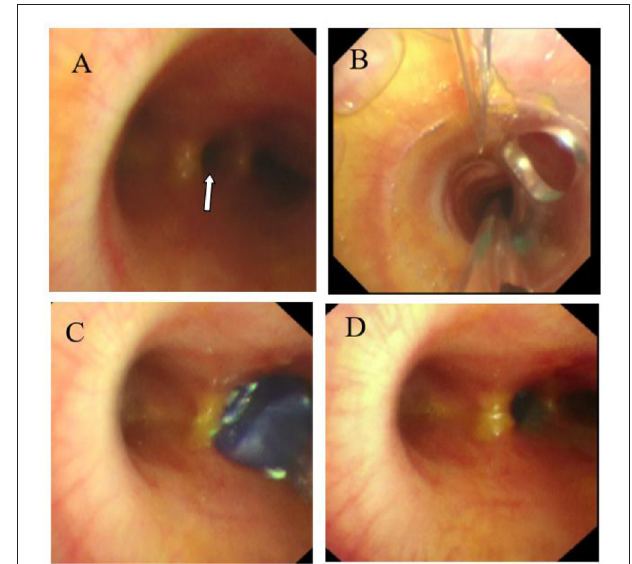
FIGURE 3 | (A) Abnormal opening of the tracheal carina (white arrow). (B) Endobronchial blocker enter into the trachea. (C) Endobronchial blocker enter into the fistula. (D) The endobronchial blocker was inflated and fixed after entering the